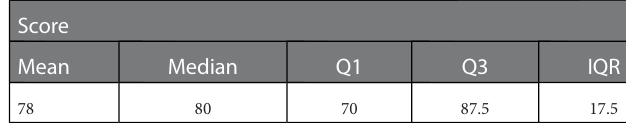
TABLE 3 Obtained score of system usability